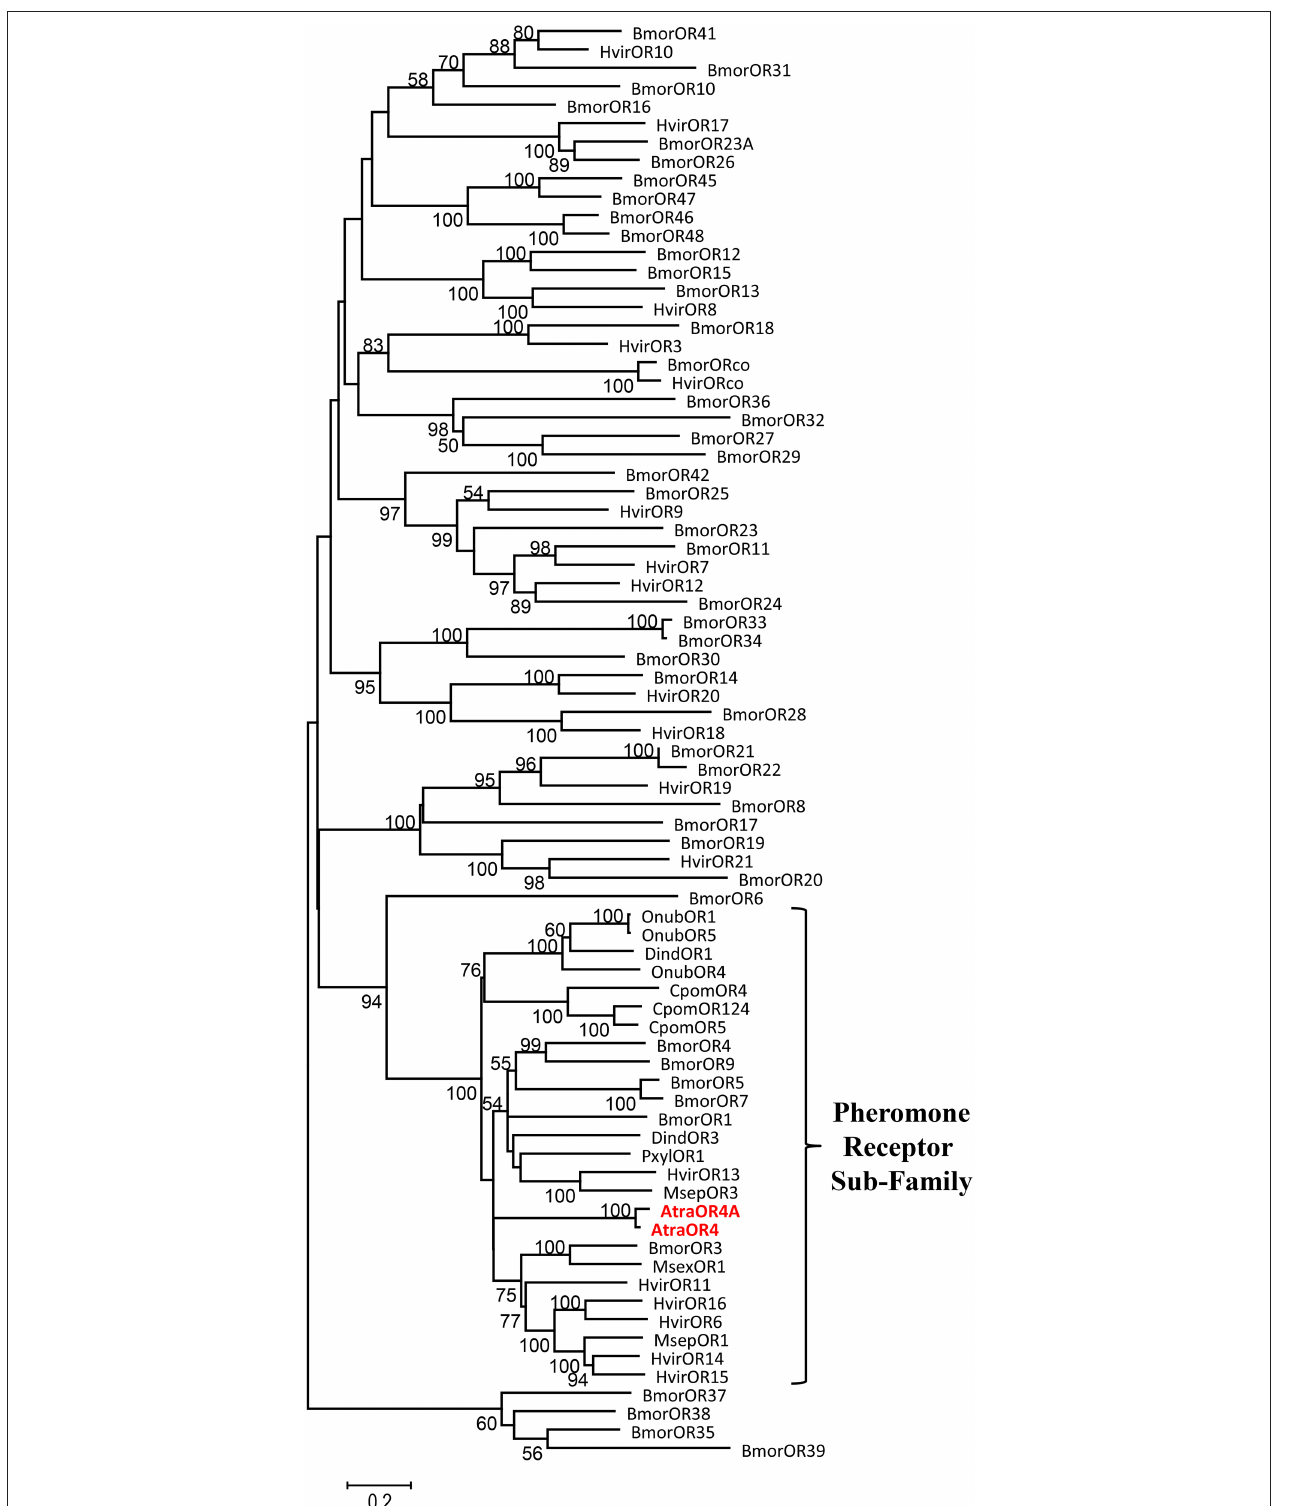
FIGURE 2 | Neighbor joining tree of AtraOR4 and AtraOR4A with 78 lepidopteran ORs, including 26 putative pheromone subfamily receptors from the following insects: Bombyx mori (Bmor), Heliothis virescens (Hvir), Ostrinia nubialis (Onub), Manduca sexta (Msex), Cydia pomonella (Cpom), Plutella xylostella (Pxyl), Mythimna separata (Msep), Diaphania indica (Dind), and Amyelois transitella (Atra).